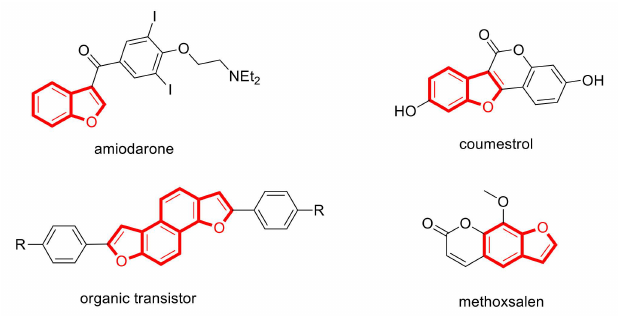
Figure 1. Selected biologically active benzofuran